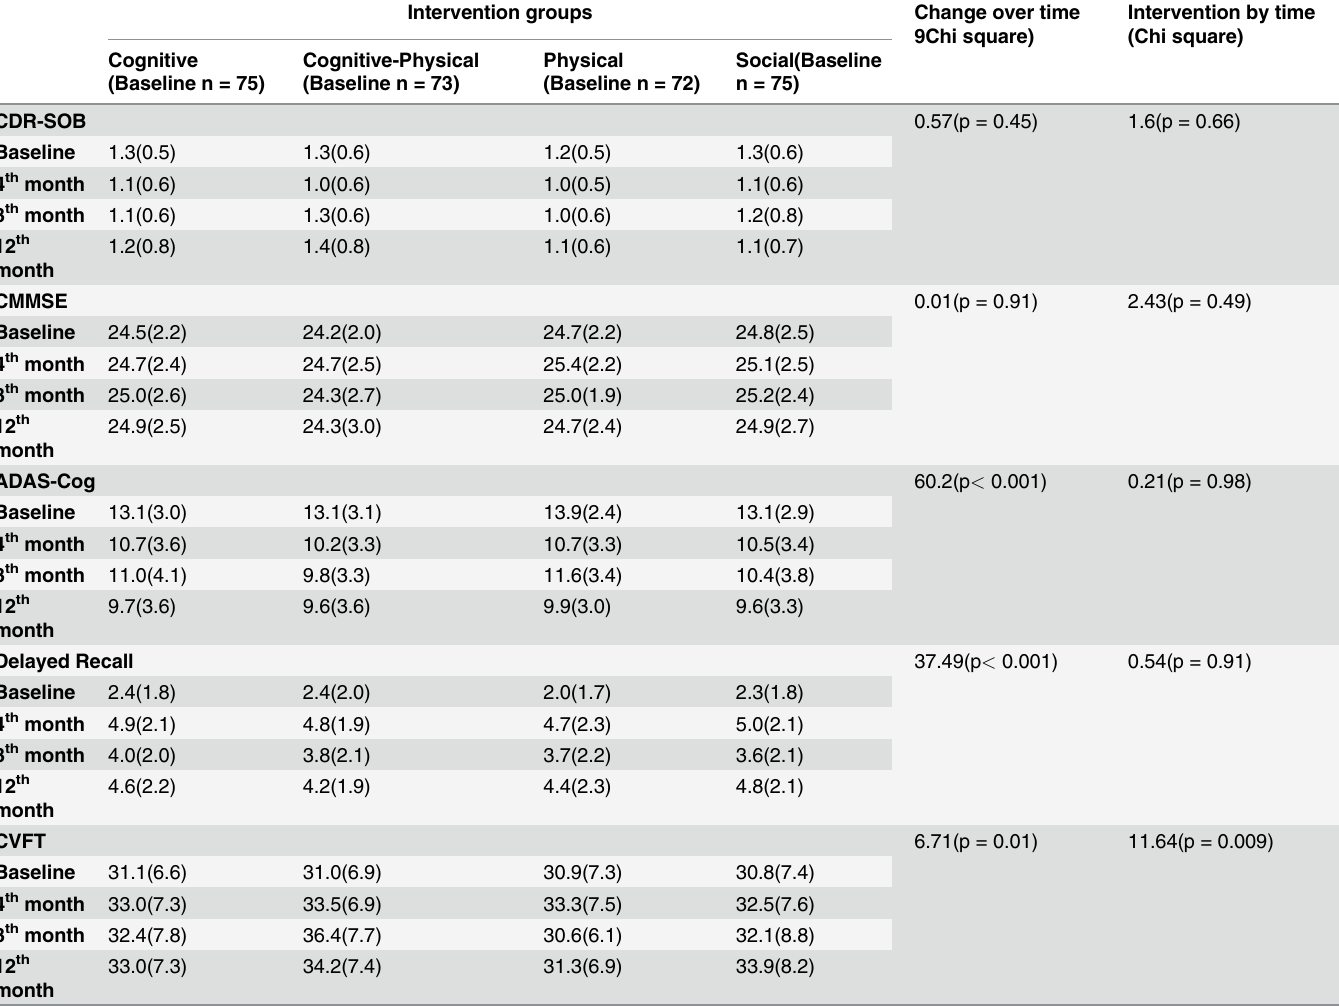
Table 5. Effects of activity intervention on cognitive and mood outcomes for participants with MCI-multiple domains deficits (Intention-to-treat